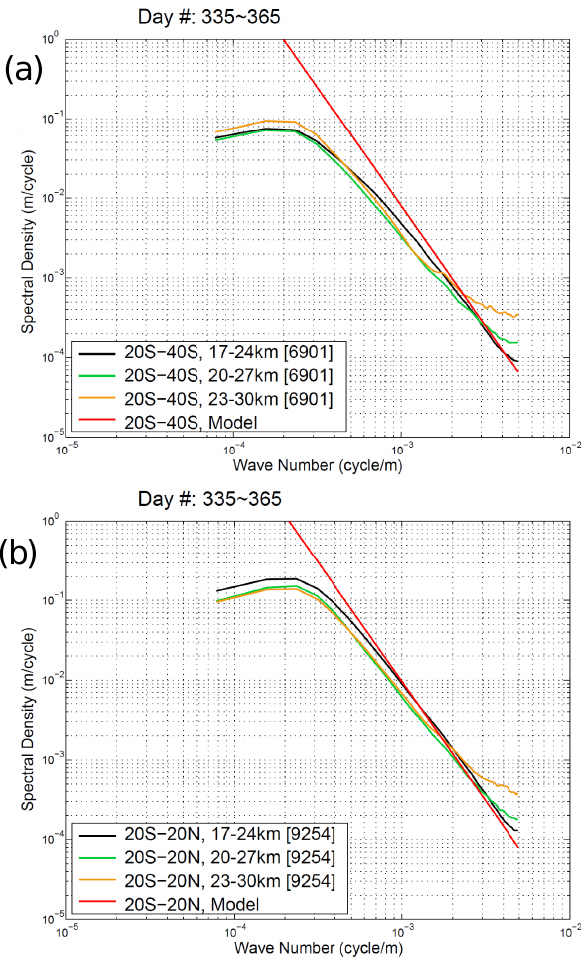
Fig. 7. Vertical wave number spectra using the FSI method at (a) 20 ◦ –40 ◦ S and (b) 20 ◦ S–20 ◦ N in altitude ranges of 17–24km (blue), 20–27km (green), and 23–30km (orange). The red line shows the model spectrum with N 2 = 5 . 50 × 10 − 4 (rad 2 s − 2 ) and 6 . 02 × 10 − 4 (rad 2 s − 2 ) for (a) and (b) , respectively.